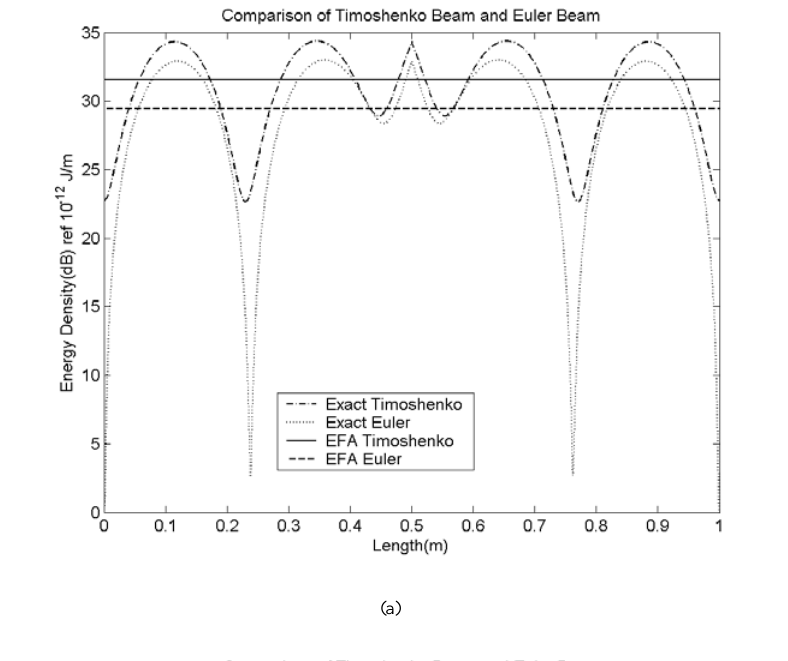
the excitation frequency and damping loss factor increase, the results from the energy flow models between the Timoshenko beam and Euler-Bernoulli beam were remarkably